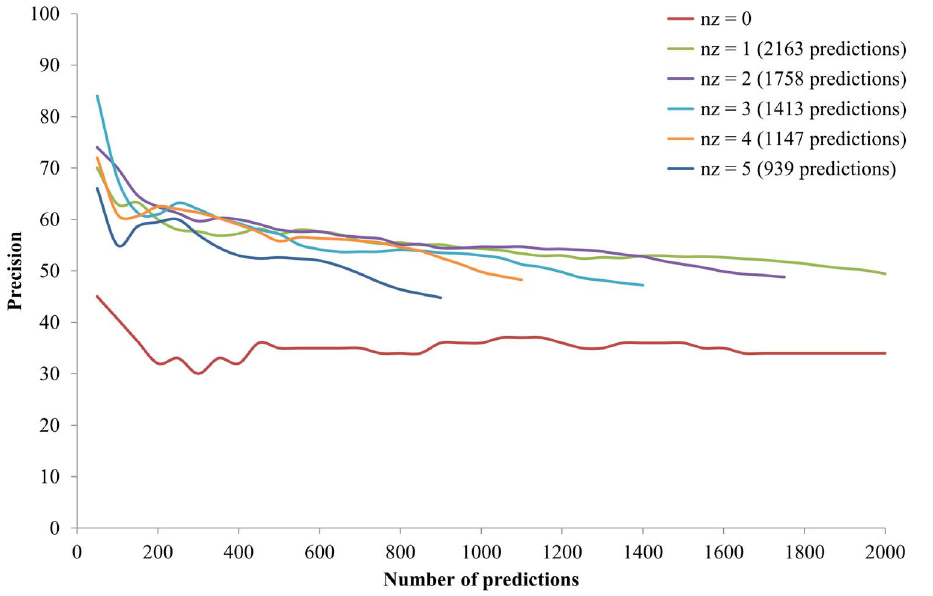
Figure 5.Performance of using different non-zero ( nz ) thresholds. The y -axis is the ratio of correct predictions predicted in the top n predictions ( x -axis). doi:10.1371/journal.pone.0075940.g005 PLOS ONE |